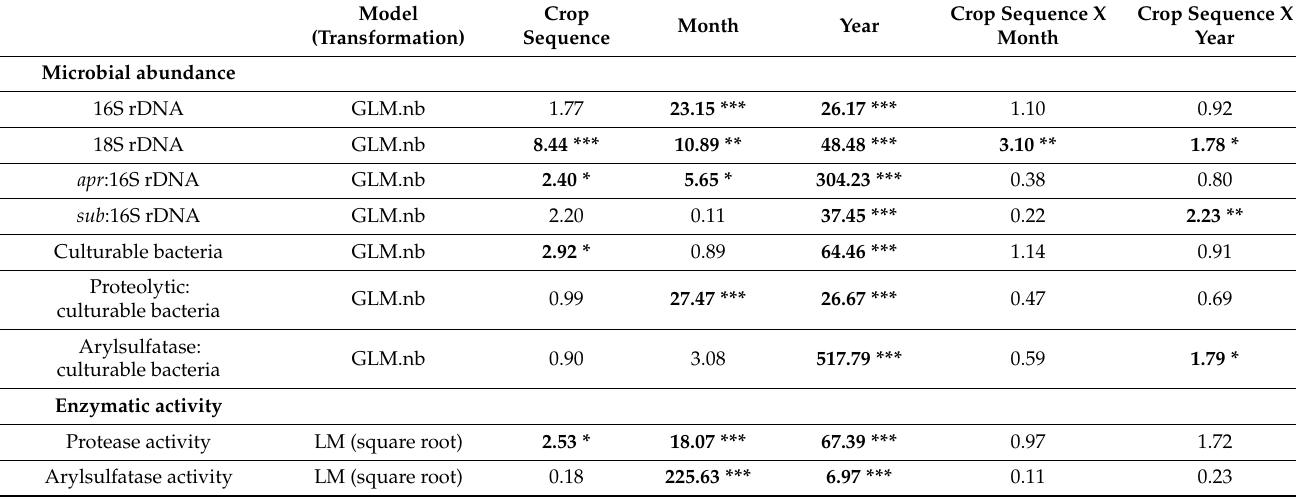
Table 1. F values from the two-way ANOVA with interaction, with crop sequence, year and month as factors. Bold indicates a significant effect. * p < 0.05; ** p < 0.01; *** p < 0.001. LM: linear model, GLM.nb: generalized linear model with negative binomial error distribution. Functional gene relative abundance is expressed relative to the eubacterial abundance, and functional groups of culturable bacteria are expressed relative to the total culturable eubacterial